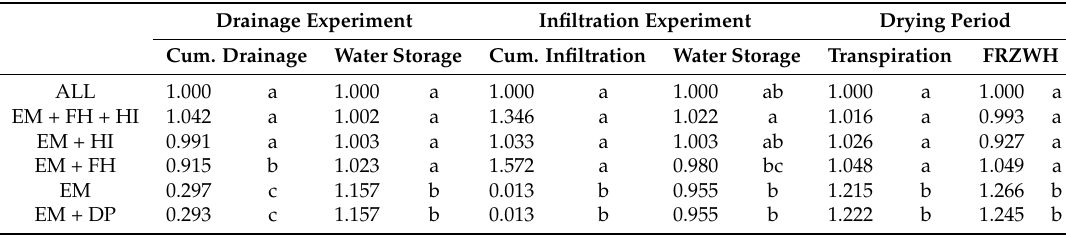
Figure 3. Modelling results. ( a ) cumulative drainage in mm; ( b ) final water volume in mm, both from drainage experiment; ( c ) cumulative infiltration in mm; ( d ) final water volume in mm, both from infiltration experiment; site-based simulations: ( e ) transpiration in mm day − 1 ; ( f ) mean water head in the root zone in cm. Values of ( b , d ) refer to a soil column of 200 cm depth. Formal statistical analysis is not validly applicable as site and tillage treatment are present in the results as disturbance factors—graph only for visual expression. Table 5. Relative comparison of modelling result; absolute model results were normalized by the corresponding result for ALL within data units of the same site and tillage treatment. Here presented is the mean of normalized values. Letters aside indicate corresponding groups identified by ANOVA and a post-hoc Tukey HSD-Test, α = 0.05. FRZWH is final root zone water head, Cum. means cumulative.